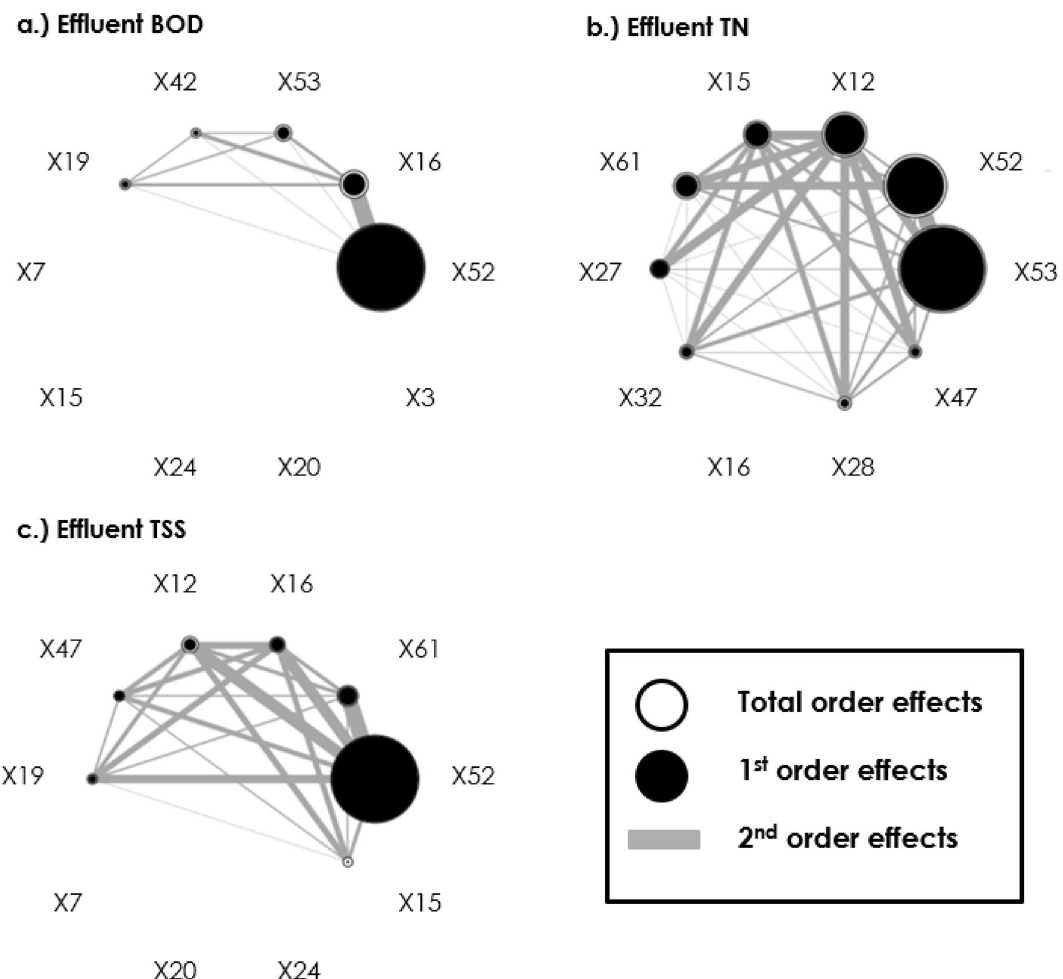
Figure 6. Second-order interactions and relative influence of the first and total order effects of investigated parameters on ( a ) BOD, ( b ) TN, and ( c ) TSS models.